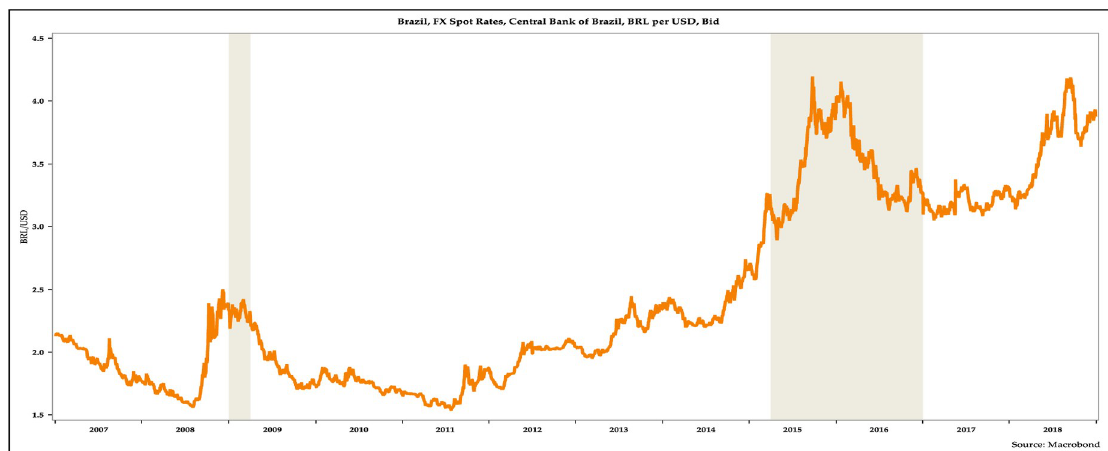
Fig 6. The evolution of the Brazilian real, 2007–2018.